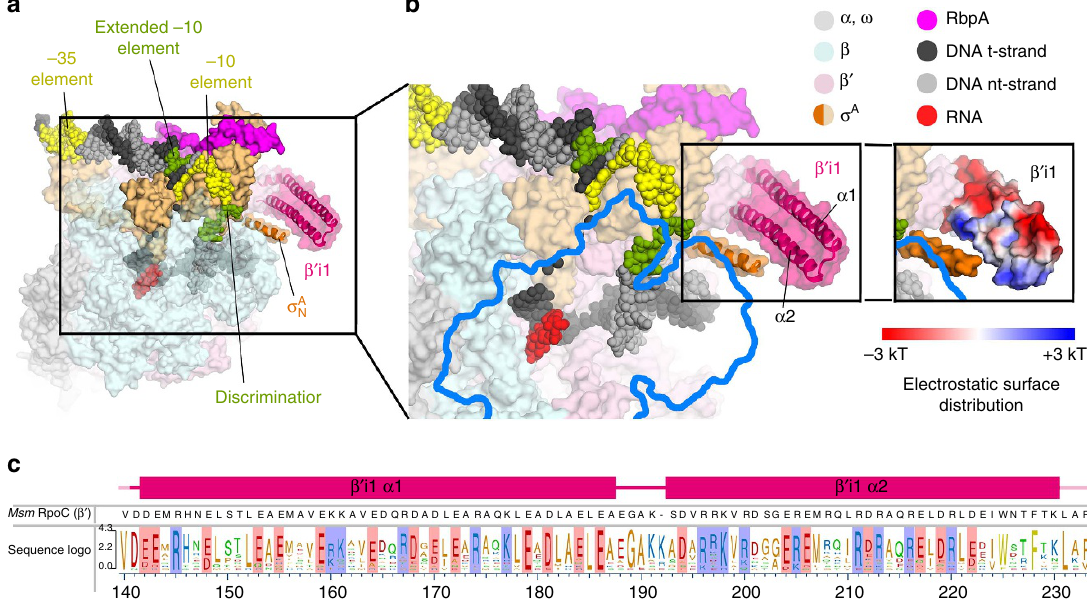
Figure 4 | The Actinobacteria b 0 i1. ( a ) Overall view of the Msm RbpA/RPo. The color-coding of most of the structural features is denoted in the legend (Fig. 3b). Protein components (core RNAP, s A , RbpA) are shown as molecular surfaces. The surface of the RNAP b subunit is transparent, revealing the nucleic acids and s A elements located in the RNAP active centre cleft. The surfaces of s A N and the lineage-specific insert b 0 i1 are transparent, revealing the a -carbon backbone ribbons underneath. The nucleic acids are shown as CPK atoms. The boxed region is magnified in Fig. 3b. ( b ) Magnified view of the boxed region from Fig. 3a. Obscuring elements of the RNAP b subunit have been removed (outlined in blue), revealing the nucleic acids in the RNAP active site cleft. The boxed region shows b 0 i1, with the two a -helices ( a 1, a 2) labelled. The boxed region on the right shows the same view of b 0 i1 but with the molecular surface coloured according to the electrostatic surface potential (red, (cid:2) 3kT; blue, þ 3kT) 66 , illustrating the asymmetric charge distribution. ( c ) The secondary structure of the Msm b 0 i1 ( Msm b 0 residues 141–230, Msm numbering shown at the bottom) is schematically illustrated ( a -helices are shown as rectangles), with the Msm b 0 sequence shown below. The sequence logo 67 shown below was derived from a sequence alignment of 720 Msm b 0 i1 homologues (all Actinobacteria). Conserved negatively charged (D/E) and positively charged (K/R) positions on the a -helices are shaded red or blue, respectively. The a 1 harbours 14 positions of conserved negative charge and 6 positions of conserved positive charge (net charge (cid:2) 8), while a 2 harbours 7 positions of conserved negative charge and 9 positions of conserved positive charge (net charge þ